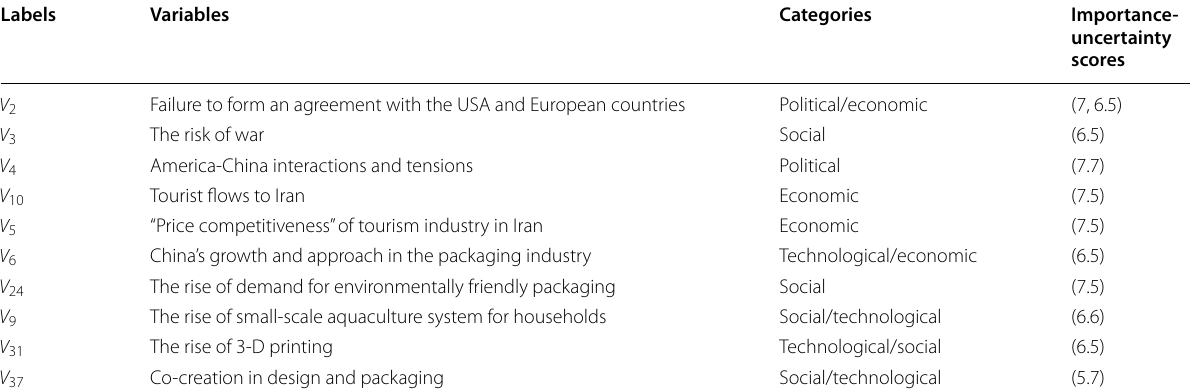
Table 3 Selected 10 variables as key